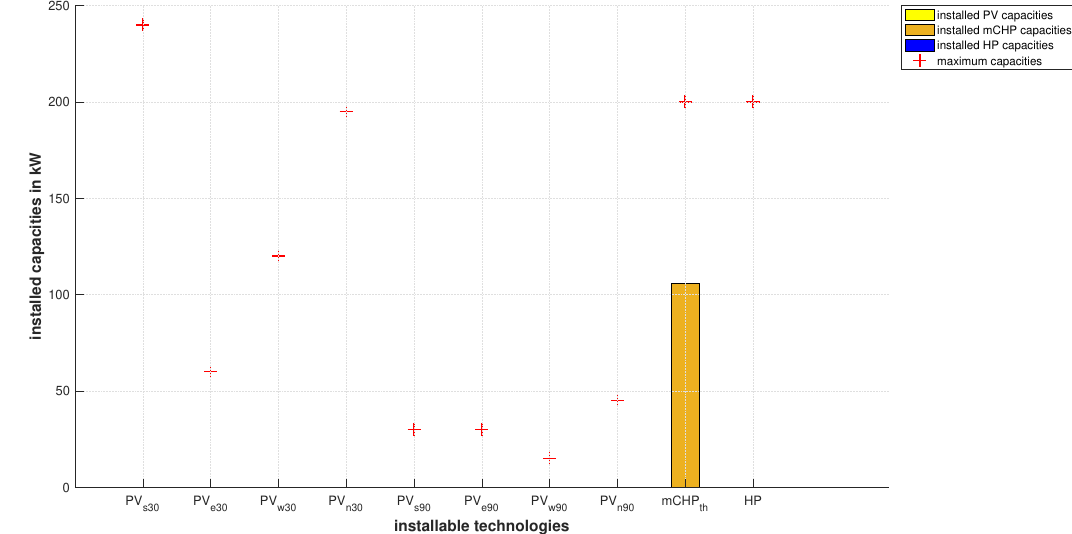
Figure 6. Installed local energy capacities for the external contractor business case.